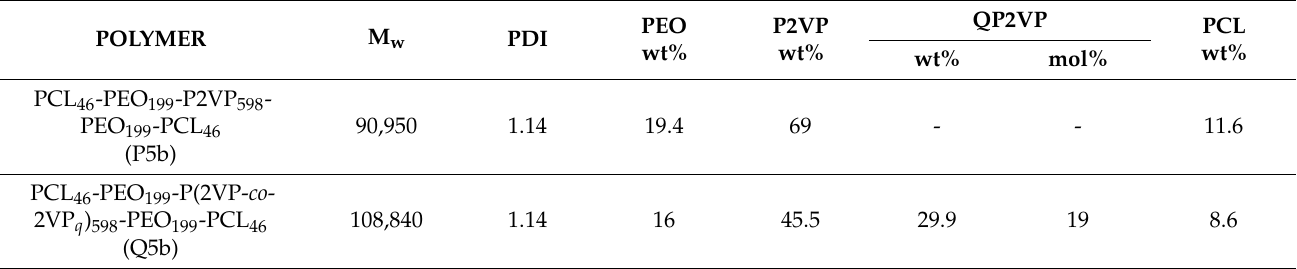
Table 1. Molecular characteristics of the